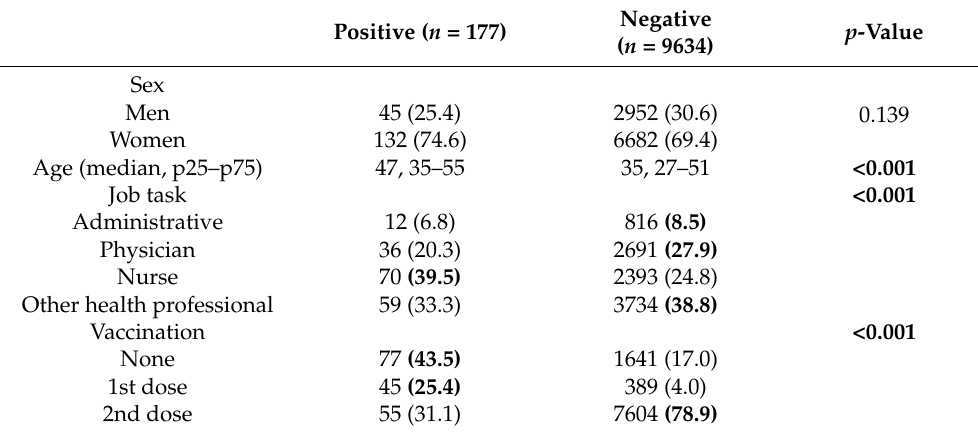
Figure 1. Cumulative incidence of SARS-CoV-2 infections in 9811 HWs of the University Hospital of Verona, Italy, estimated by the Kaplan–Meier method. Time zero was the start of the vaccination campaign (27 December 2020) for the red curve (Group A), 14 days after the 1st dose for the blue curve (Group B), and 14 days after the 2nd dose for the green curve (Group C). Table 2. Main demographic and professional characteristics and vaccination status of the 9811 HWs, by SARS-CoV-2 swab test